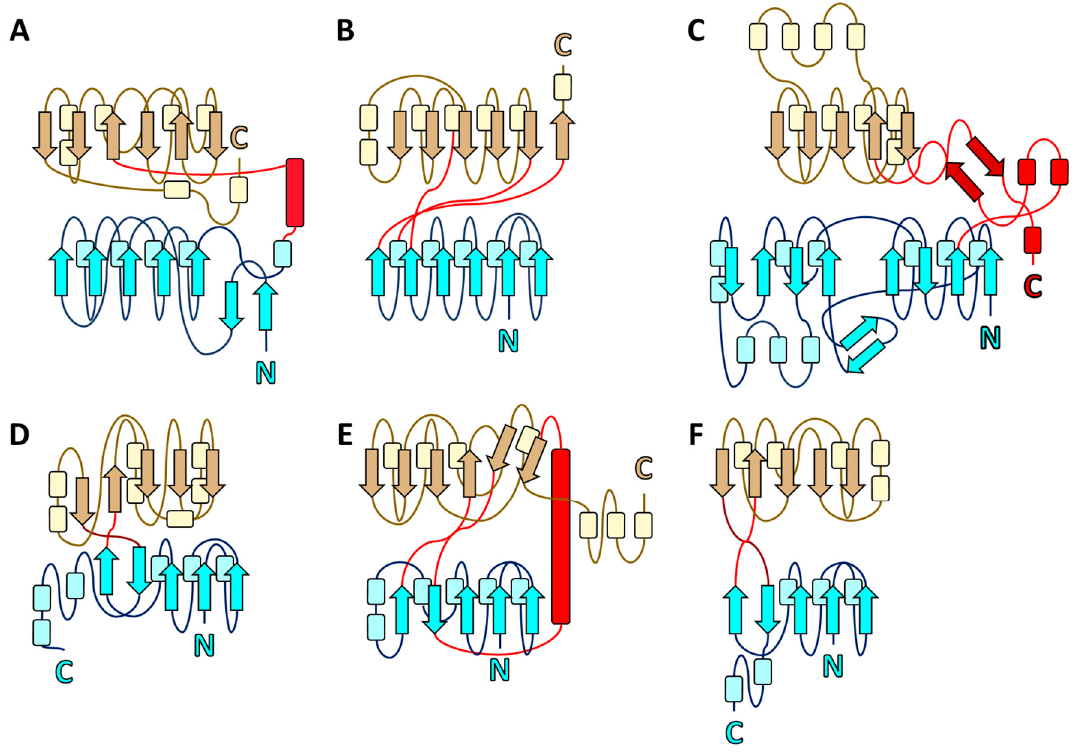
Figure 7. Topology diagrams of representative proteins of the Class II PBPs. For each diagram, secondary structural elements (not to scale) are arrows for β strands, cylinders for helices (all types), and lines for loops. Secondary structural elements are colored cyan (strands), light blue (helices), and blue (loops) for Domain I; crimson (strands) and red (loops and helices) for Domain II; and brown (strands and loops) or yellow (helices) for Domain III. Clusters ( A ) (HtsA from Staphylococcus. aureus ; PDB ID 3EIW), ( B ) (GGBP from Escherichia coli ; PDB ID 2FVY), ( C ) (OppA from Salmonella. typhimurium ; PDB ID 1JET), ( D ) (phosphate-binding protein from E. coli ; PDB ID 11XH), ( E ) (TTHA0776 from Thermus thermophilus HB8; PDB ID 2ZZV), and ( F ) (ModA from Azotobacter vinelandii ; PDB ID 1ATG).